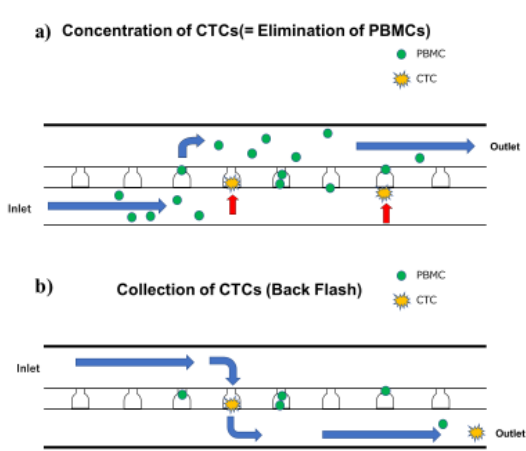
Figure 1. Cell retrieval using Celsee PREP100 ® combined with On-chip Sort ® . ( a ) Circulating tumor cells (CTC) enrichment was performed with Celsee. ( b ) CTCs and still contaminating peripheral blood mononuclear cells (PBMCs) were recovered by reverse injection of buffer. Red arrows indicate captured CTC. Blue arrows mean direction of buffer flow.